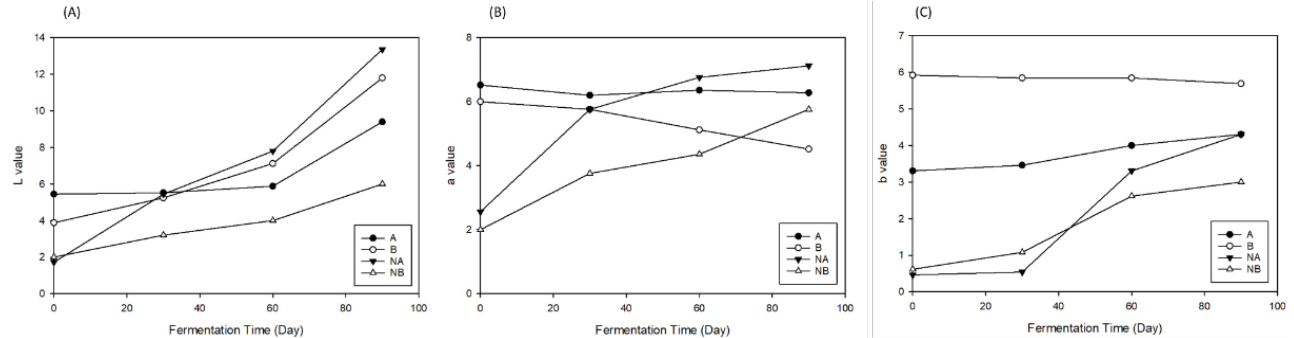
Figure 6. The changes in color parameters in L value ( A ), a value ( B ), and b value ( C ) during secondary fermentation.